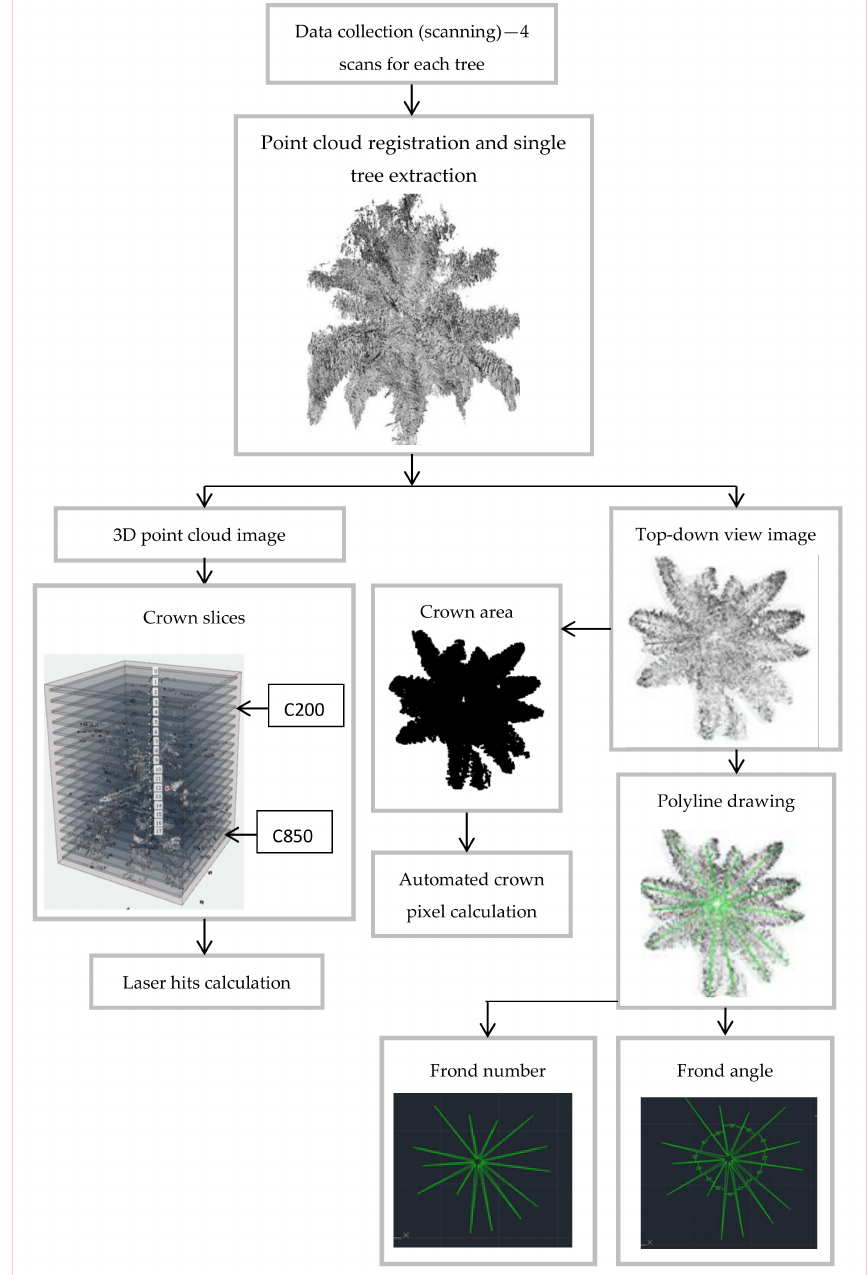
Figure 3. Schematic of the method used for feature